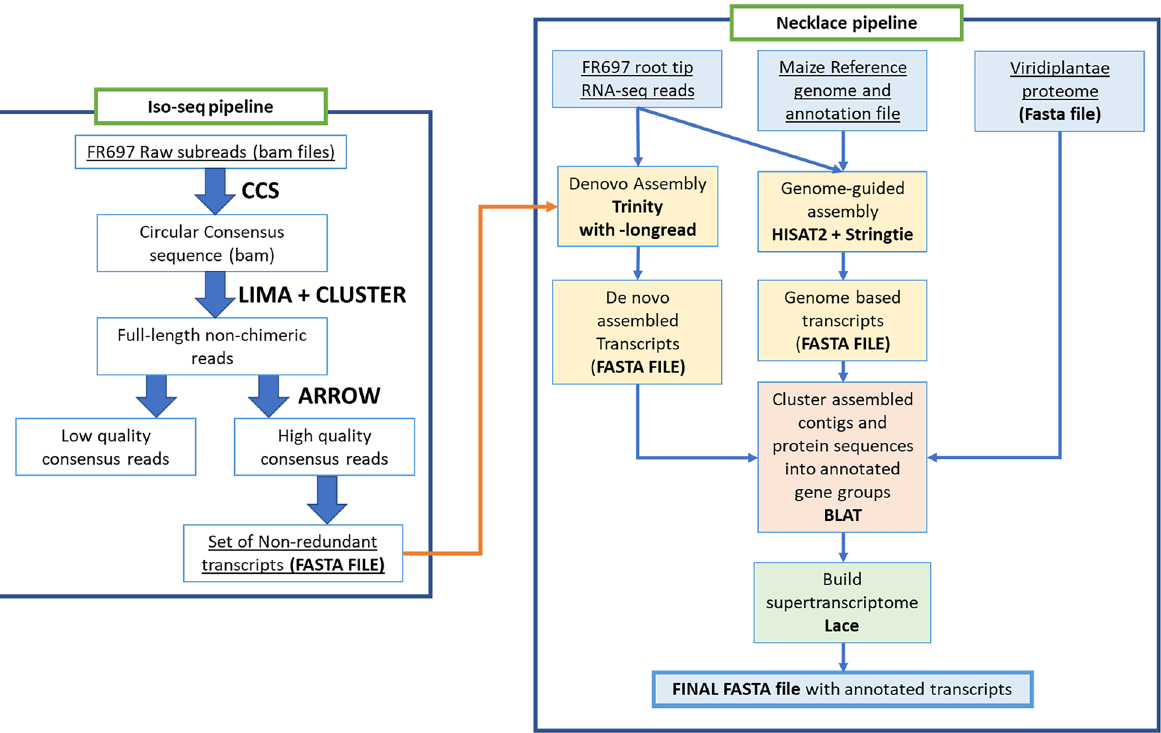
Figure 3. Overview of the steps to assemble the FR697 transcriptome. The first part consists of the Iso-Seq pipeline to generate a set of long read transcripts from Iso-Seq reads. These transcripts were used along with the RNA-Seq short read samples for a trinity transcriptome assembly. The trinity assembly along with a reference guided transcriptome assembly and the Viridiplantae proteome is combined by the Necklace pipeline, which generates a consensus “SuperTranscriptome” assembly, with the final output being a transcriptome fasta file with annotations.